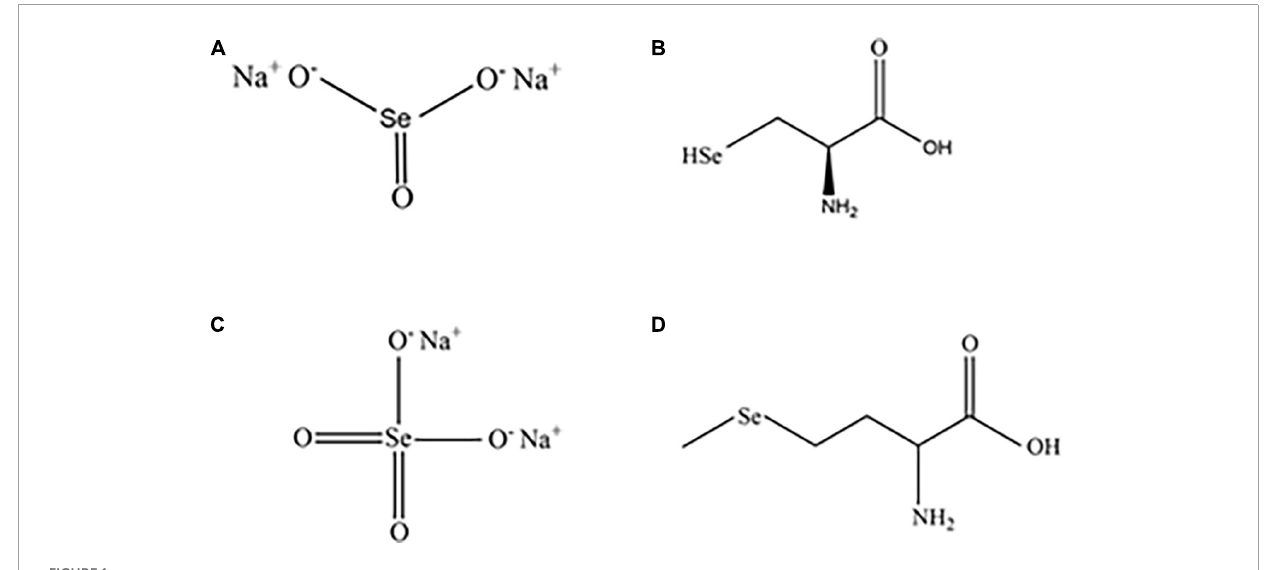
FIGURE1 Structures of common inorganic and organic selenium compounds. Sodium selenite (A) , sodium selenate (B) , SeC (C) , and SeM (D)